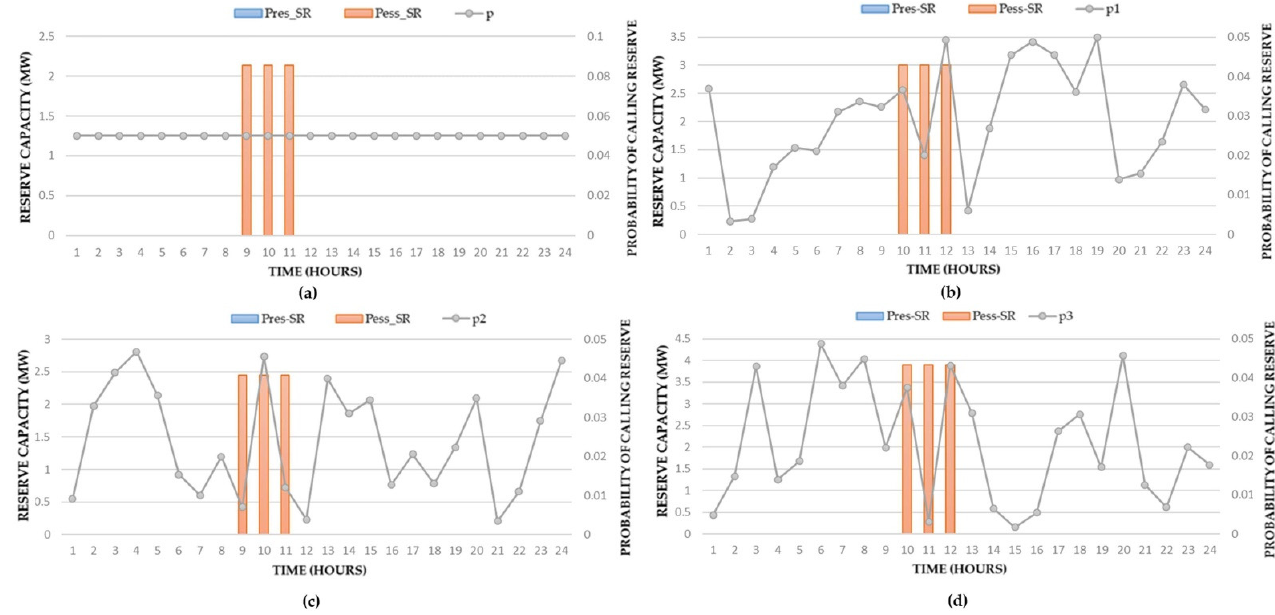
Figure 13. The VPP’s reserve bidding with reserve probability: ( a ) p = 0.05 for all hours, ( b ) scenario p 1 , ( c ) scenario p 2 , and ( d ) scenario p 3 with RES’ maximum power output of 20